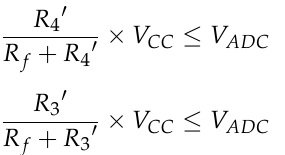
Figure 5. Transducer grounding bleeder circuit.